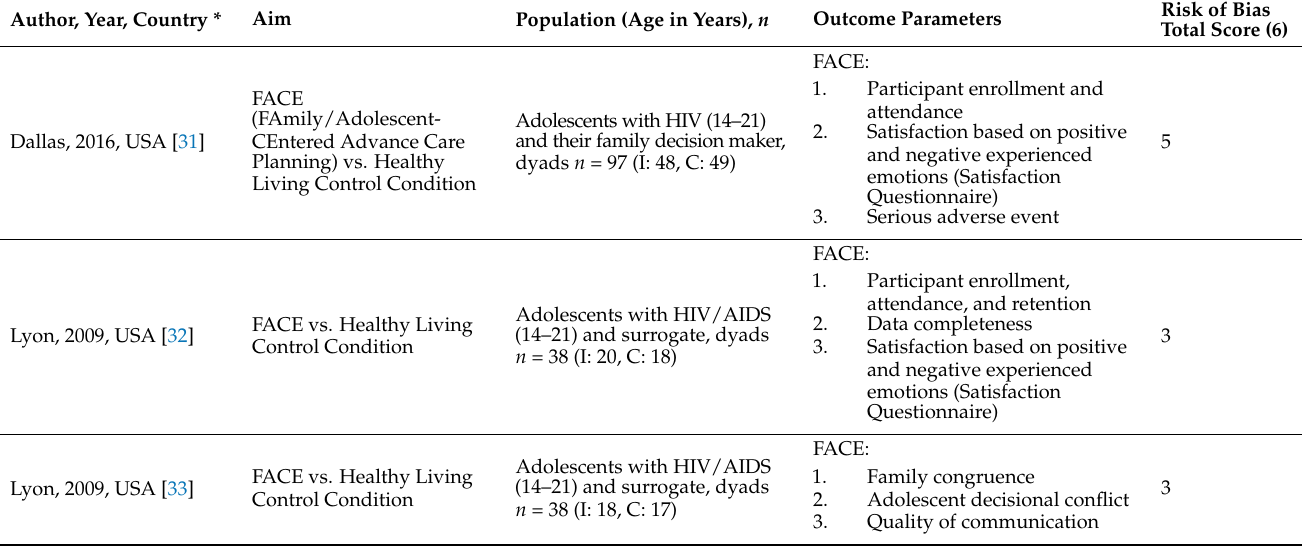
Table 2. Evidence from randomized controlled